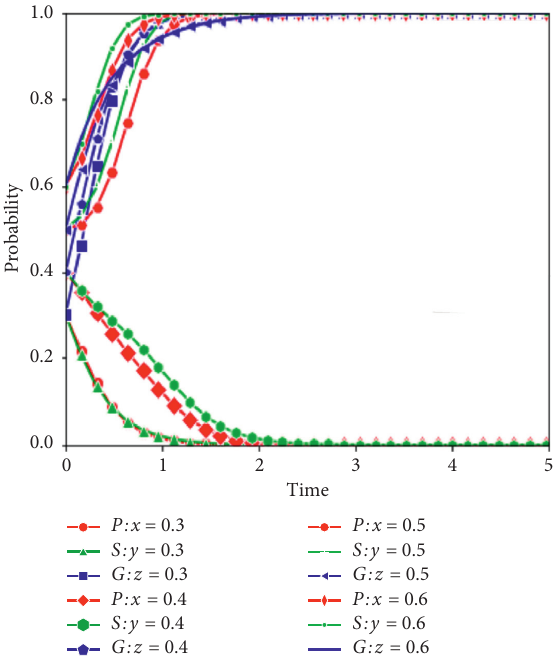
Figure 1: Dynamic evolution process of the tripartite game sub- jects when x , y , and z change simultaneously.